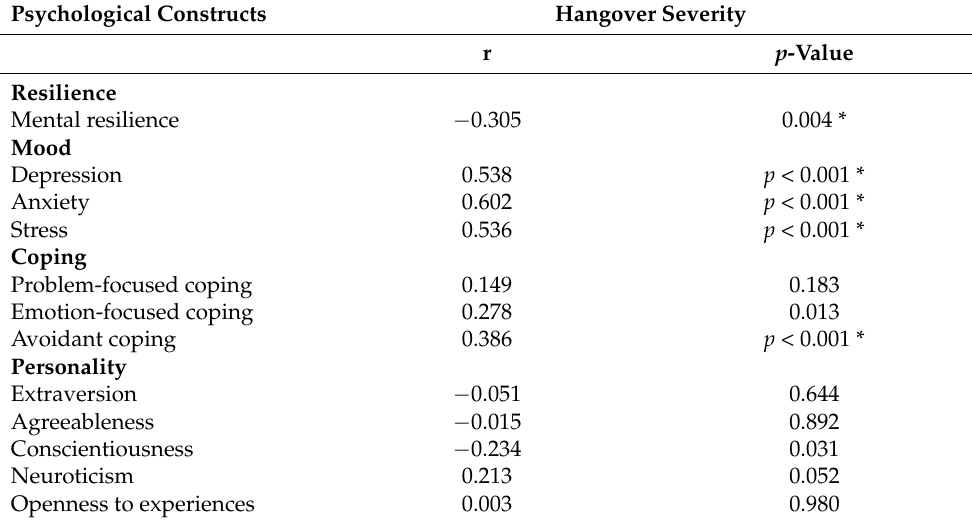
Table 4. Psychological constructs and their association with hangover